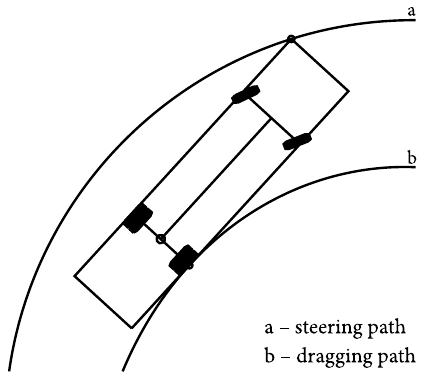
fig. 1. Vehicle movement